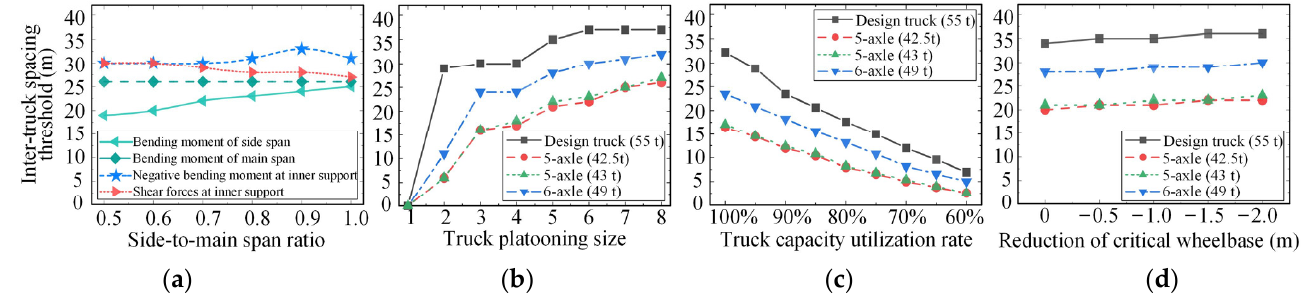
Figure 12. Parametric analysis of inter-truck spacing threshold: ( a ) effect of side-to-main span ratio; ( b ) effect of truck platooning size; ( c ) effect of truck capacity utilization rate; ( d ) effect of reduction in the critical wheelbase.